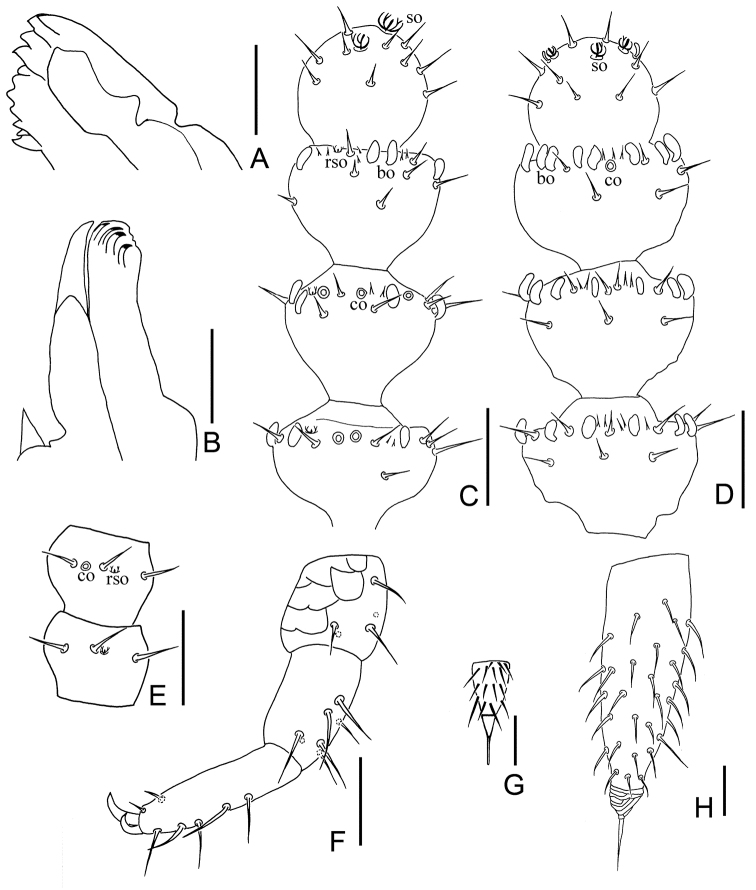
Symphylellamacropora sp. n. A mandible B first maxilla C–D 15th–18th segments of left antenna C dorsal view (bo-bladder-shaped organ, co-cavity-shaped organ, rso-rudimentary spined sensory organ, so-spined sensory organ) D ventral view E 4th–5th segments of right antenna, dorsal view F 12th leg G stylus on base of 4th leg H right cercus, dorsal view. Scale bars: 20 μm (A–F, H); 5 μm (G).